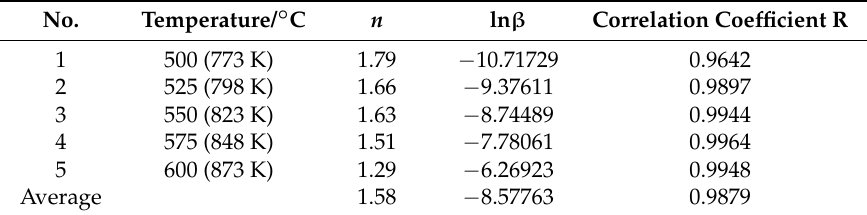
Table 2. Parameters of Equation (5) for the selected process temperatures.